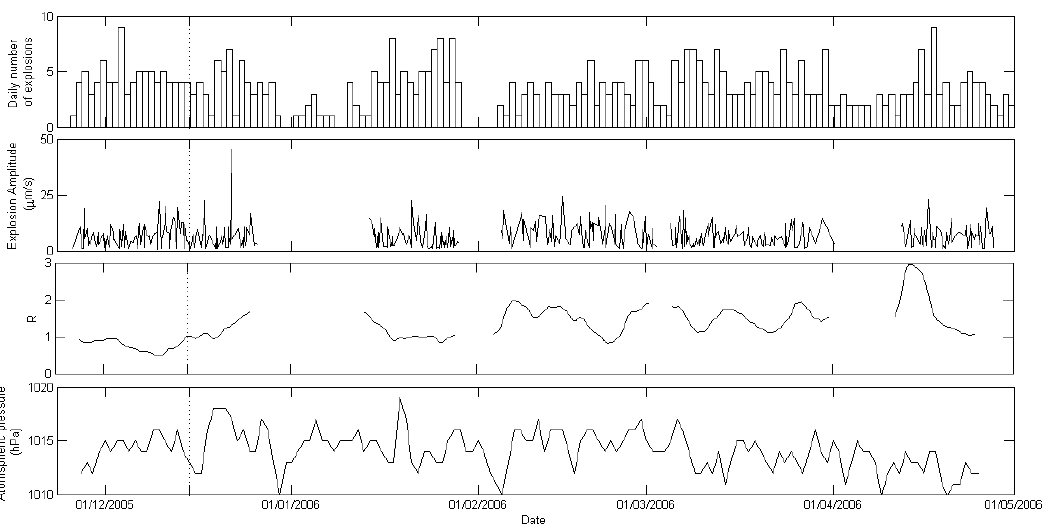
Fig. 10. Time-evolution of the density (upper panel), and amplitude (second panel from the top) of volcanic explosions, R (third panel from the top) and atmospheric pressure (bottom panel). Dotted vertical line separates Phase A and Phase B. We do not observe statistically relevant modifications of the volcanic parameters along the data set, whereas correlations between R and atmospheric pressure appear. See the text for details.